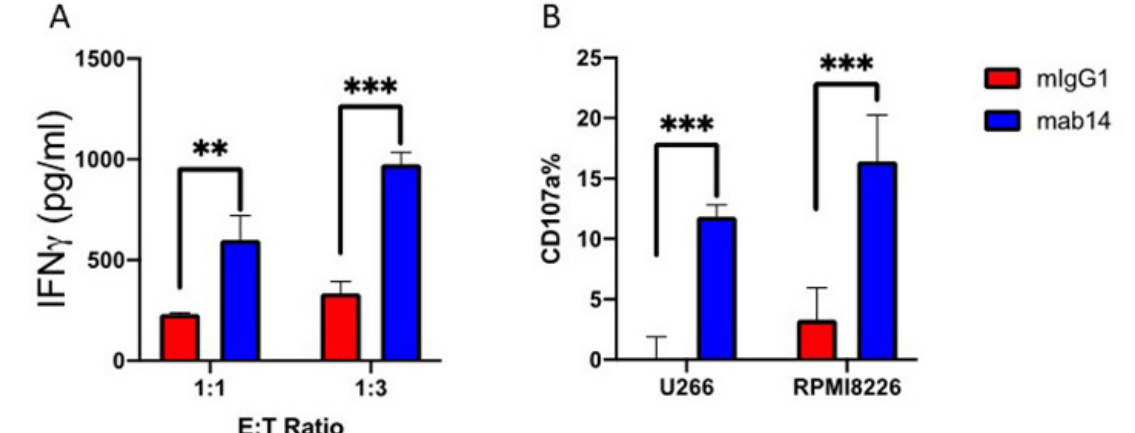
Figure 4. Blocking the membranal-PCNA on MM cell lines enhances IFN- γ secretion and degranu- lation of NK cells. ( A ) Primary NK cells from a healthy donor were incubated with U266 cell lines and mAb 14-25-9 or mIgG1 for 18 h using different ratios of effector:target (1:1 and 1:3). IFN- γ was measured by ELISA. ( B ) Primary NK cells from a healthy donor were incubated either with RPMI 8226 or U266 cell lines and mAb 14-25-9 or mIgG1 for 5 h. Surface CD107a was measured by flow cytometry, to detect NK cells that had degranulated. Mouse IgG1 acts as a background control (red bars) in comparison to mAb 14-25-9 (blue bars). Dead cells were discriminated against using 7-AAD. Data is shown from three independent replicates and the experiment was repeated three times. Two-way ANOVA test showed p ** < 0.01 and p *** < 0.001. Statistical analysis and design were performed using Prism GraphPad v8 (California).